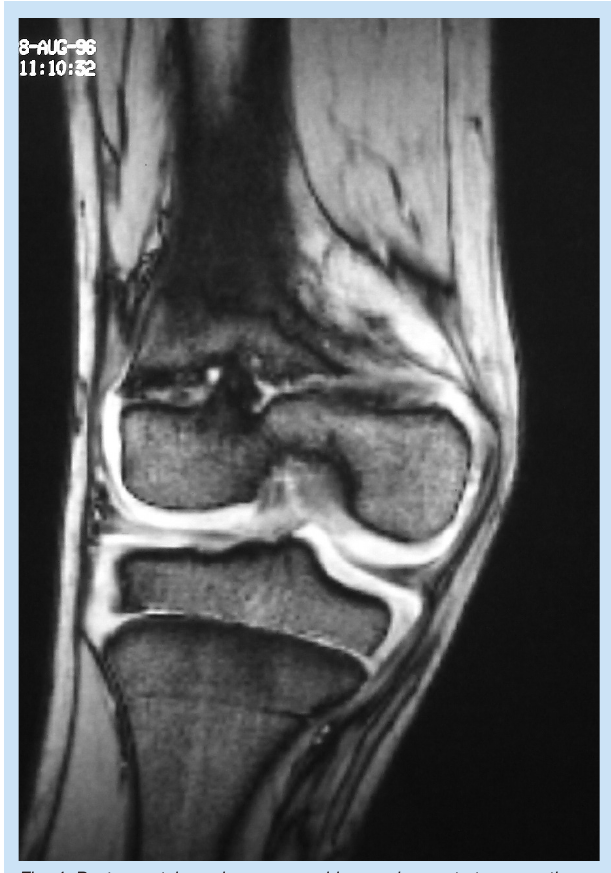
Fig. 4. Postneonatal sepsis – a coronal image demonstrates a continuous physeal bar at the distal femur with marked irregularity at the lateral half of the physis. This is in contrast to the normal regular proximal tibial physis.